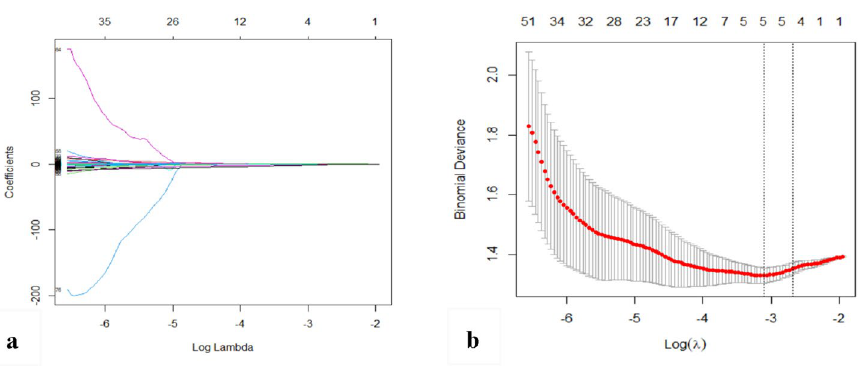
Figure 4. Feature selection using the least absolute shrinkage and selection operator (LASSO). ( a ) The coefficient distribution map of radiomics features and the features with nonzero coefficients were selected. ( b ) Adjustment parameter (λ) by tenfold cross validation. The dotted lines on the left and right represent the minimum variance principle and the most concise model principle, respectively. The minimum variance principle was adopted in this